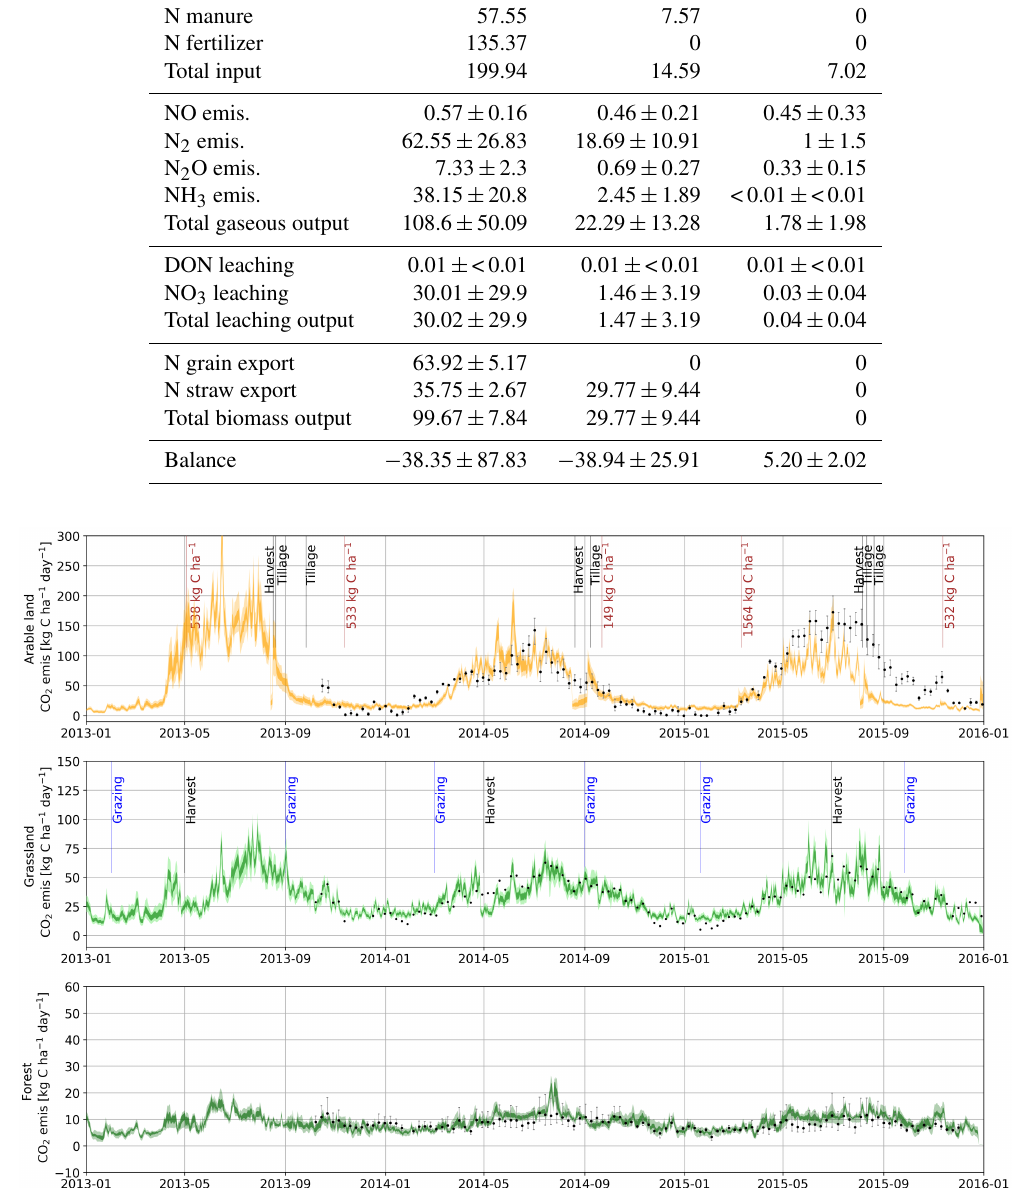
Figure 5. Modelled CO 2 emissions and management. Measurements are given as grey error bars showing the variance between the replicated transects and the mean value as a black dot. Posterior model uncertainty is given in light colour for the 5th and 95th percentiles and dark colour for the 25th and 75th percentiles. Vertical lines indicate management events. Brown coloured bars in the uppermost panel indicate manure